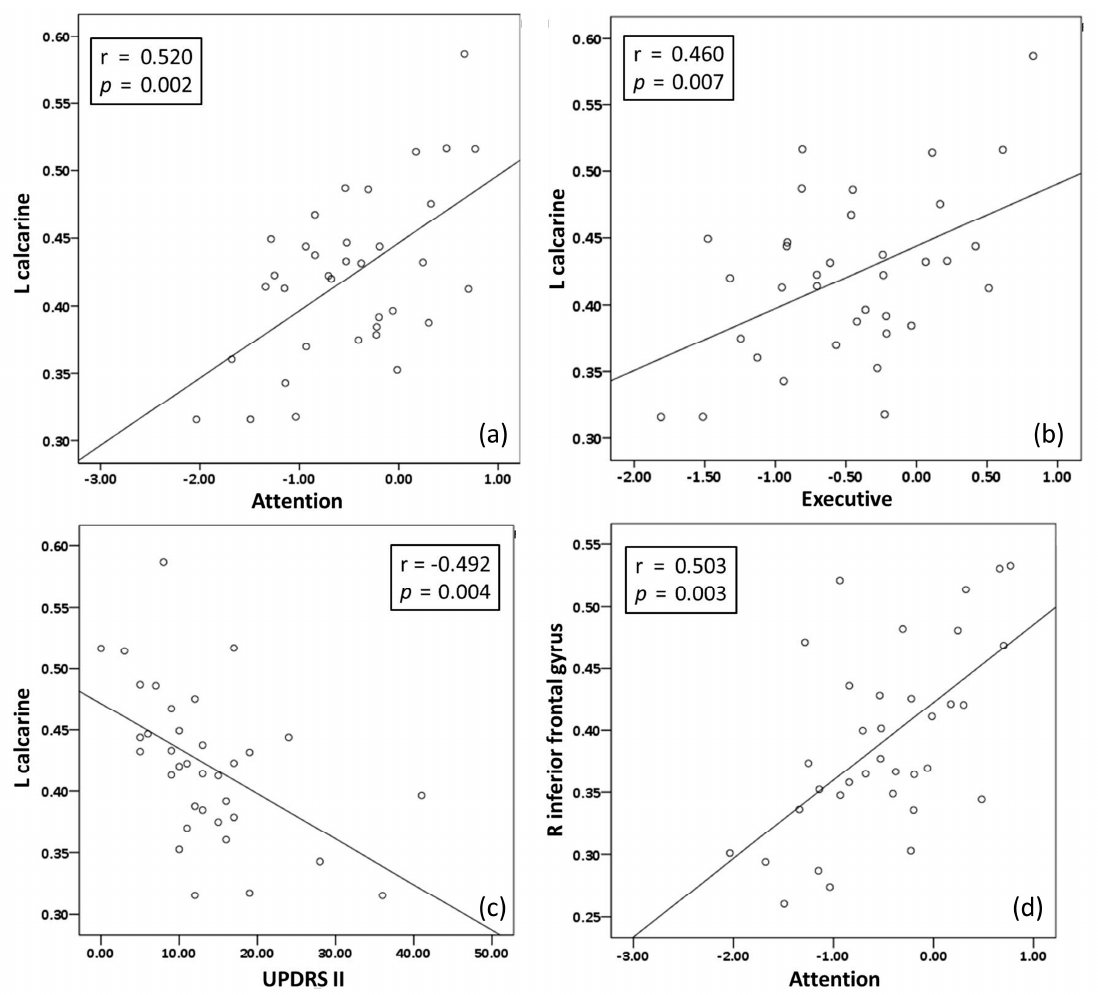
7 of 12 Figure 1. Lower gray matter volumes (GMVs) in PDD patients with fall vs without fall, with highlighted significant areas. Compared to PDD patients without fall, PDD patients with fall showed significantly lower GMV in the left inferior temporal gyrus, right inferior frontal gyrus, left caudate head, right middle occipital gyrus, left inferior frontal gyrus, left Rolandic operculum, right inferior frontal gyrus, right middle temporal gyrus, left calcarine, and right precentral gyrus. Among these areas, the clusters of left calcarine and R inferior frontal gyrus survived from statistical threshold of FWE-corrected p < 0.05. 3.3. Relationship among Disease Severity Profiles, NPT, and Extracted Regional GMV from PDD Patients UPDRS-II was the only disease severity score showing significant difference between the PDD with fall and without fall groups; moreover, it exhibited a significantly negative correlation with a